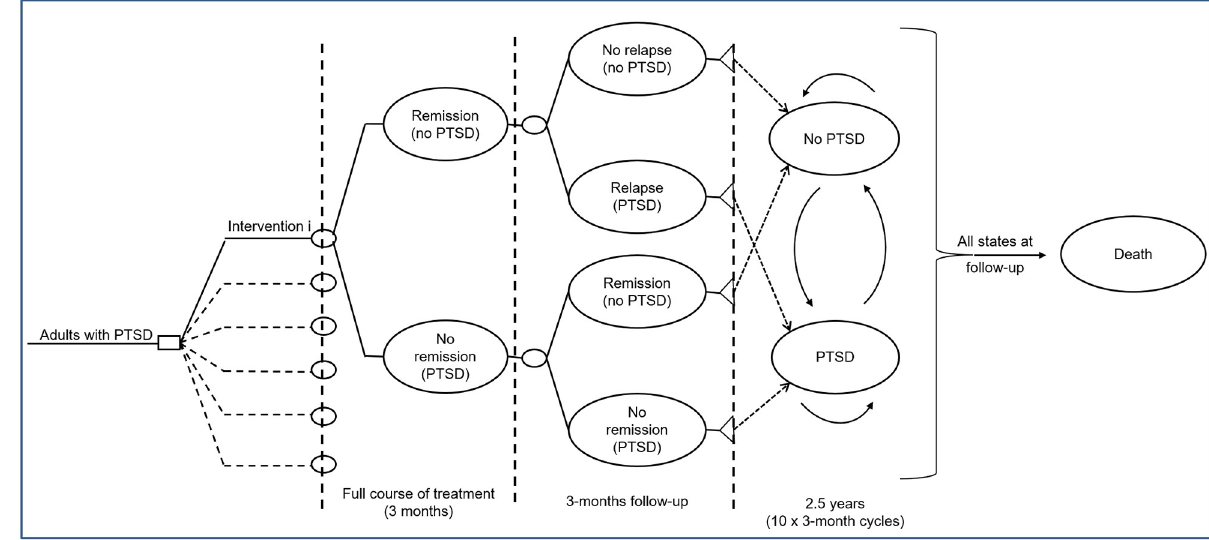
Fig 1. Schematic diagram of the economic